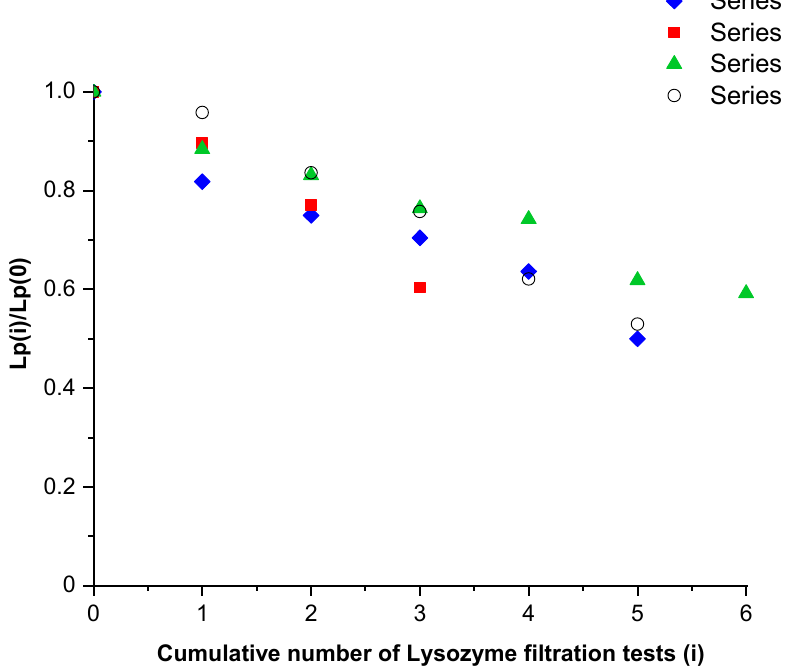
Figure 3. Relative hydraulic permeability versus the number of filtration tests of lysozyme performed.